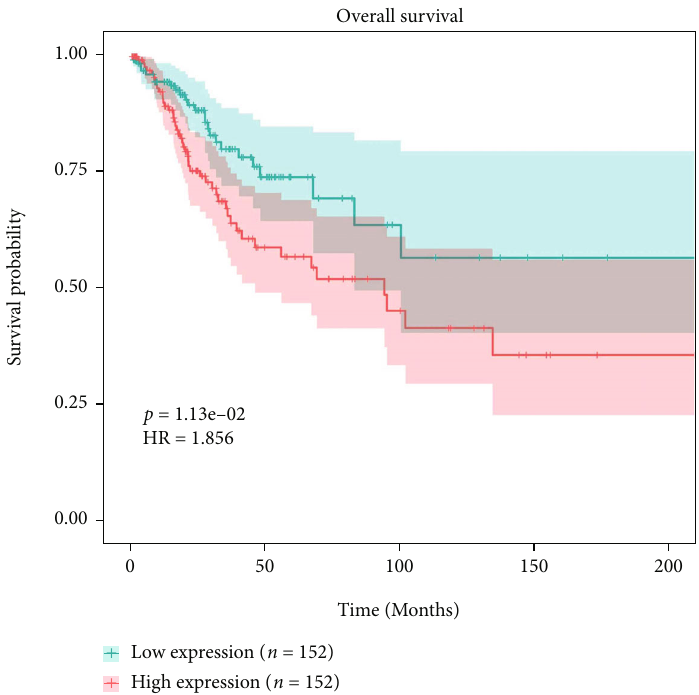
Figure 8: Di ff erence analysis of overall survival rate of SERPINE1. It is worth mentioning that the disease-free survival period of the high and low expression groups of PPP6C gene can basically be regarded as a signi fi cant di ff erence. NG